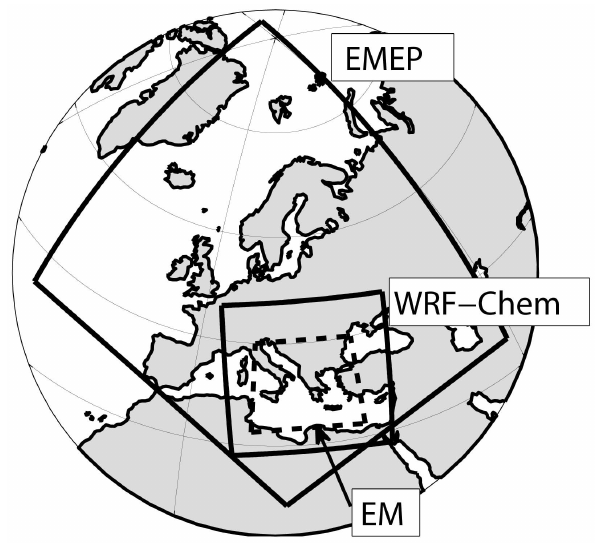
Fig. 1. Locations of the domains used in the EMEP MSC-W and WRF-Chem simulations, and of the study region (11–30 ◦ E, 32– 45 ◦ N) covering most of the Eastern Mediterranean (EM). Coordi- nates of the four corners of the two model domains are (35.8 ◦ W, 40.5 ◦ N), (16.7 ◦ E, 20.3 ◦ N), (58.6 ◦ E, 34.8 ◦ N) and (131.8 ◦ W, 86.5 ◦ N) for EMEP MSC-W, and (8.1 ◦ E, 28.2 ◦ N), (33.9 ◦ E, 28.2 ◦ N), (38.8 ◦ E, 49.8 ◦ N) and (3.2 ◦ E, 49.8 ◦ N) for